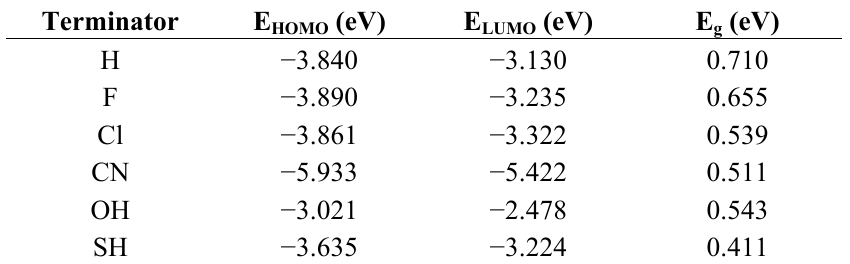
, E and E for fully terminated 6-Z-HGNS. HOMO LUMO g